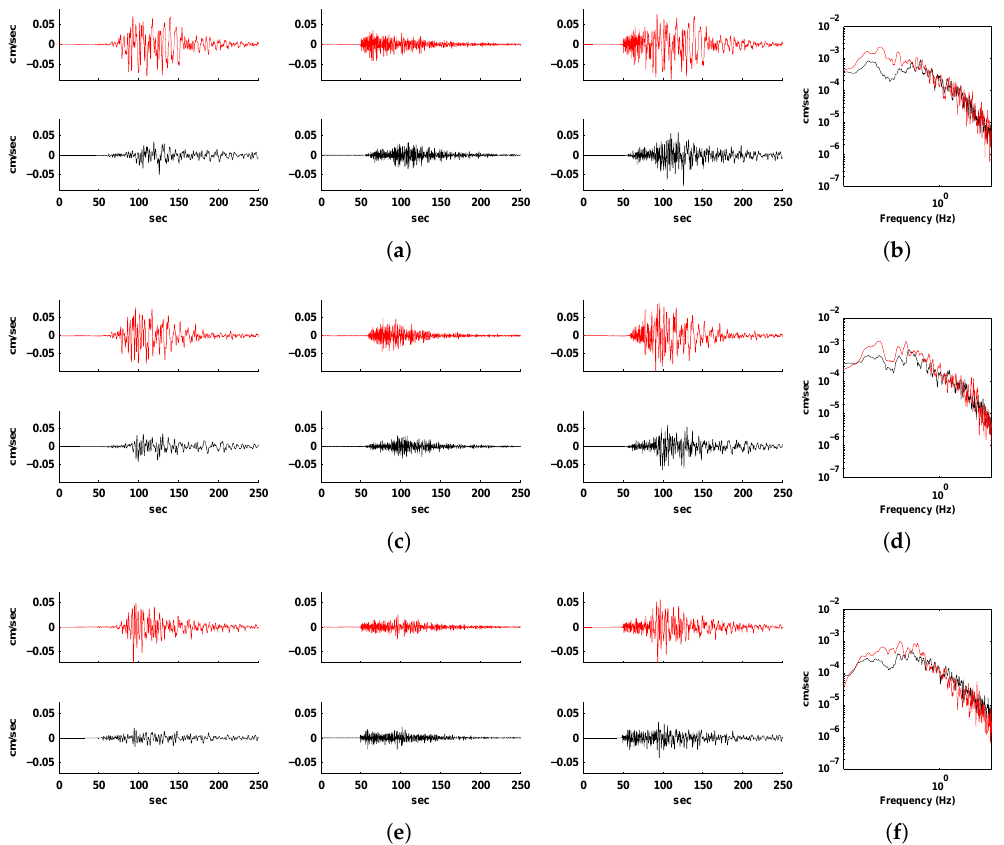
Figure 15. ( a ) North-south component, ( c ) east-west component, and ( e ) vertical component of ground velocity histories at Station 10. Shown in red are the long-period spectral-element-simulated (column 1), high-frequency EGF-synthesized (column 2), and combined broadband histories (column 3) for the 2004 Parkfield earthquake. Shown in black are the corresponding filtered observed ground velocity records for comparison. ( b , d , f ) show the comparison of the corresponding spectra of the broadband velocity histories (red: synthesized, black: observed).